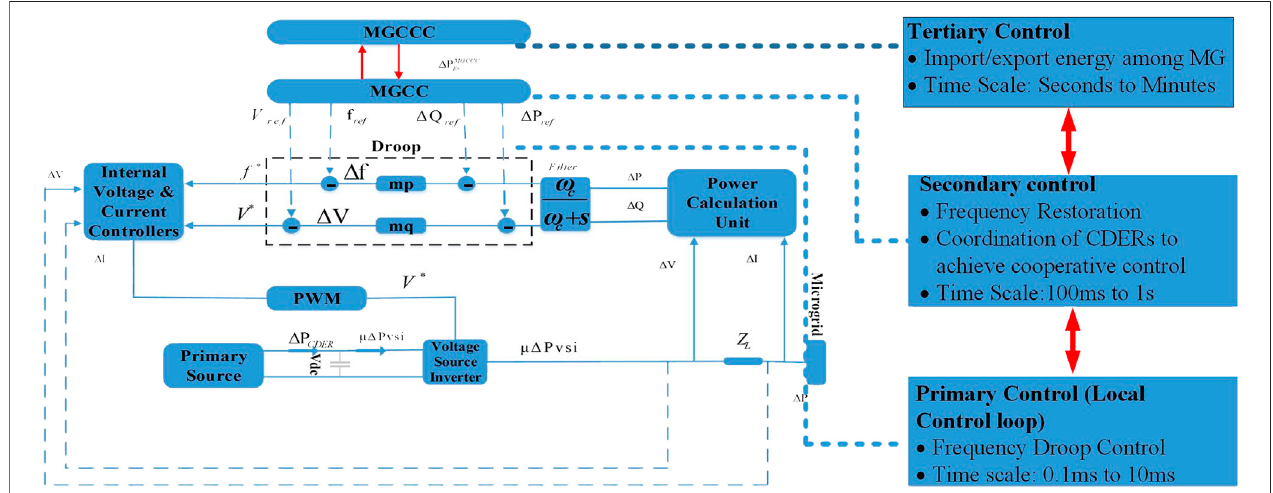
FIGURE 3 | The steady-state block diagram of the droop controlled VSI-based CDER unit hierarchical frequency control (Rezaei and Kalantar,